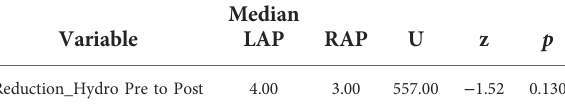
TABLE 7 Two-Tailed mann-whitney test for reduction of hydronephrosis by pyeloplasty .